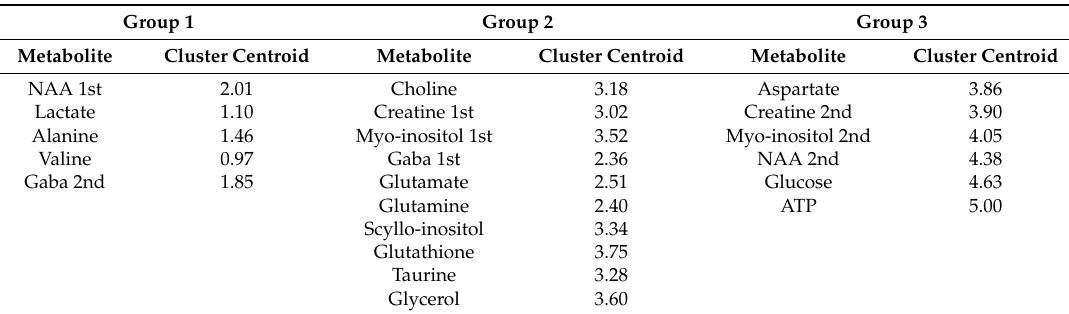
Table 1. Cluster centroids used for initializing K-means.